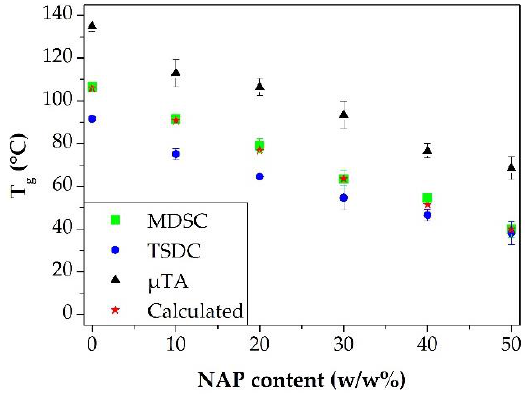
Figure 8. Comparison of the T g values measured by different techniques and investigation of their